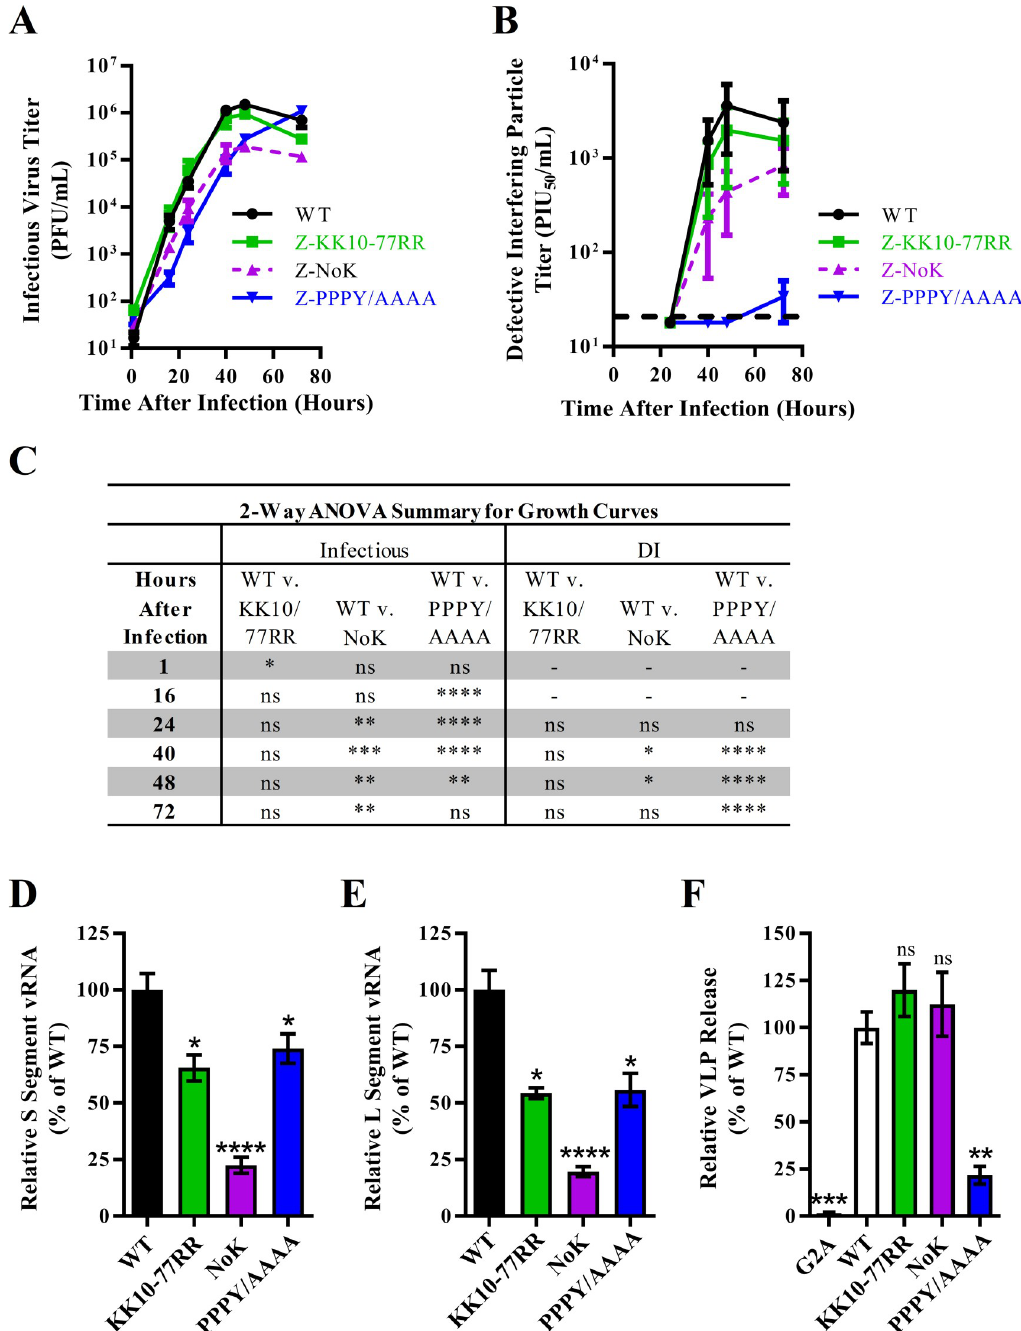
Fig 8. Loss of ubiquitination sites in LCMV Z has little impact on virus particle release. (A-B) Reverse genetics was used to generate recombinant (r)LCMV containing mutations at the two ubiquitination sites (K10 and K77) as well as a virus with a lysine-free (NoK) or a late domain-free (PPPY > AAAA) Z protein. The growth kinetics of these viruses were then measured by infecting A549 cells with these viruses and measuring the infectious titers by plaque assay (A) and DI particle titers by plaque interfering assay (B) at 1, 16, 24, 40, 48 and 72 hours after infection. (C) Summary of a two-way ANOVA with Holm-Sidak’s test for multiple comparisons used to compare the log-transformed mean titer values from the growth curve in (A-B). (D-E) Viral RNA was isolated from clarified cell culture media from the 72 hours post-infection time point in (A-B) and the quantities of genomic S-segment (D) or L-segment (E) vRNA were determined by quantitative real time RT-PCR. (F) The release of virus- like particles (VLPs) from HEK293T cells transfected with plasmids expressing SBP-tagged LCMV Z protein with the indicated mutations was measured. The graphs in (A-B and D-F) represent the mean values ± SEM of three independent experiments